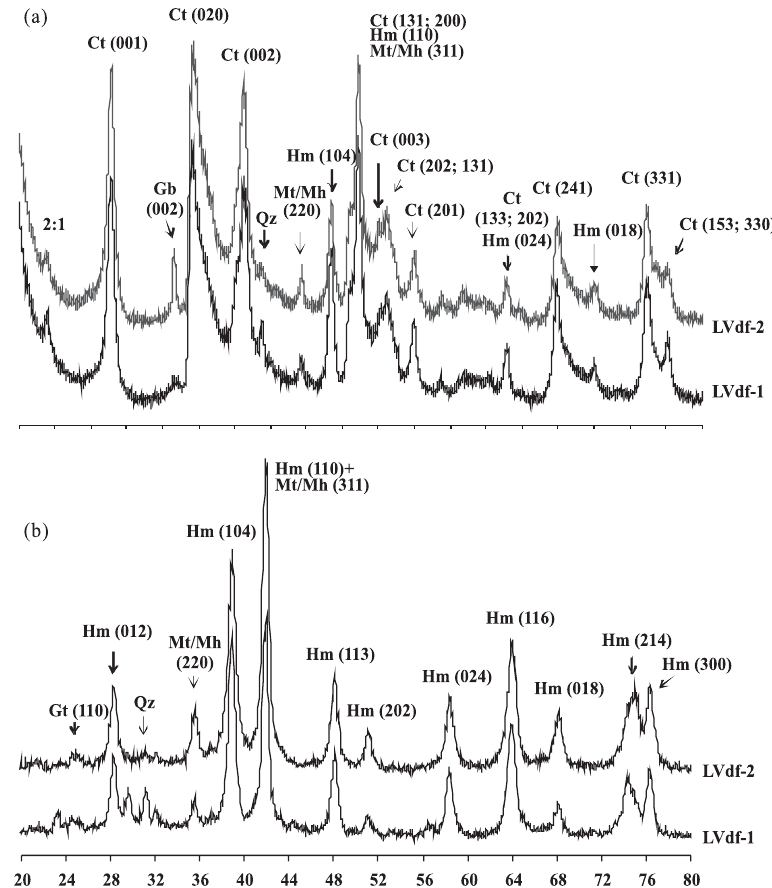
Figura 1. Difratogramas de raios X das frações argila total (a) e óxidos de Fe concentrada (b) dos solos LVdf- 1 e LVdf-2. Ct: caulinita; Gb- gibbsita; Qz: quartzo; Mt- magnetita; Mh: maghemita; Hm: hematita; Gt-